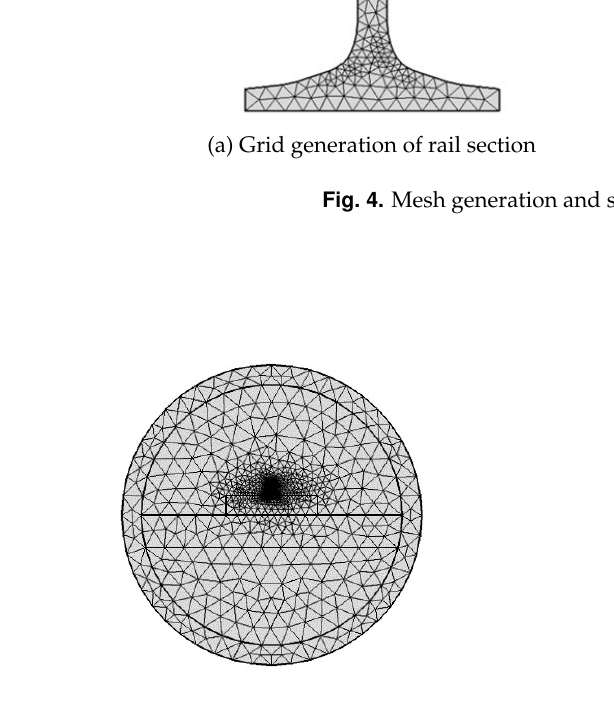
Fig. 5. Mesh generation of external impedance.